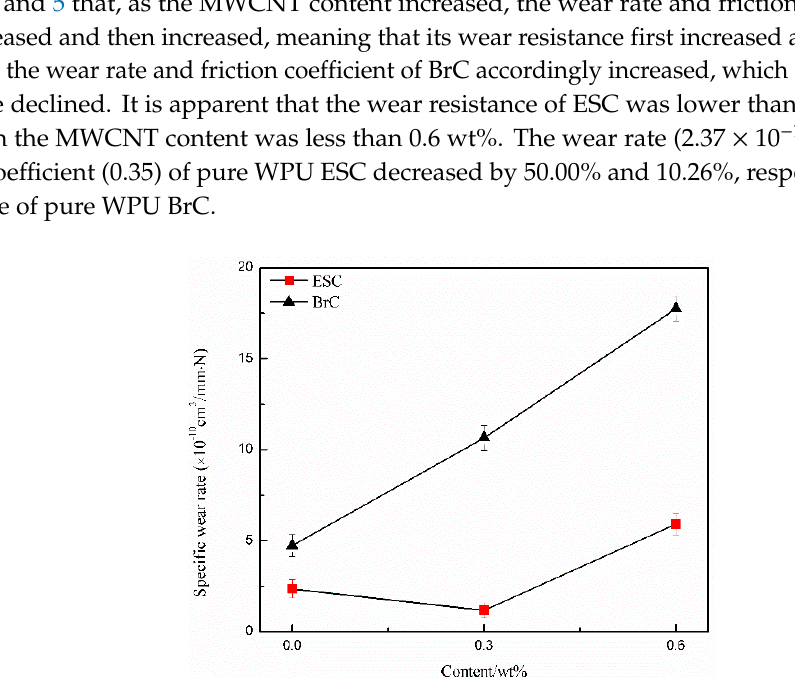
Figure 4. Wear rate curves of ESC and BrC with different MWCNT content.